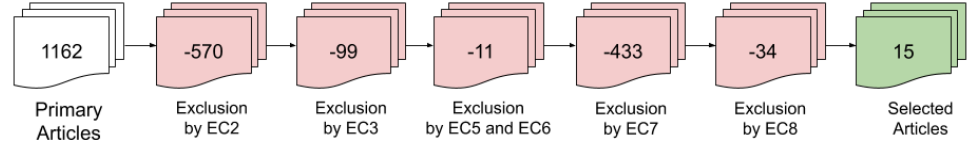
Figure 3. Electronic search stages.